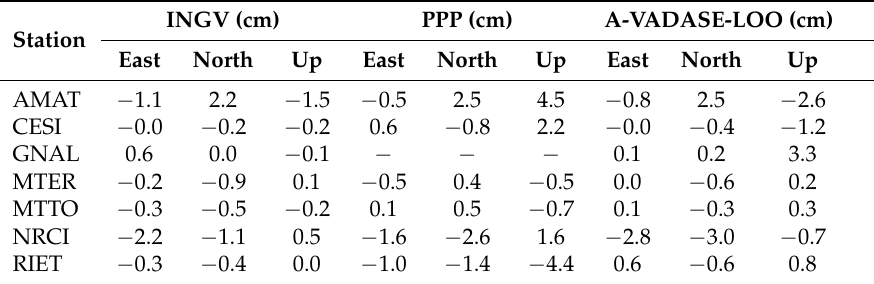
Table 5. Coseismic displacements: 24 August 2016 earthquake.